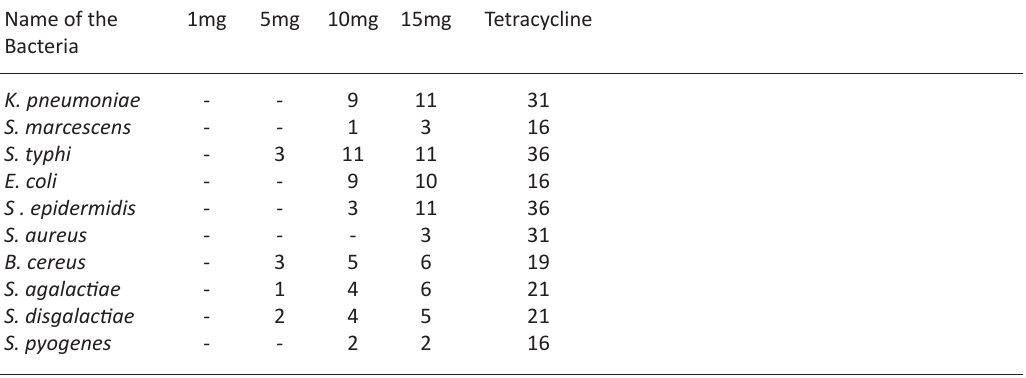
Table 2. Antibacterial activity using A. indica extract with acetone against bacterial pathogens Name of the